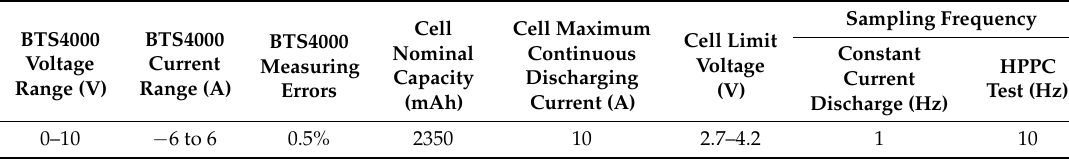
Table 1. The important parameters of the experimental